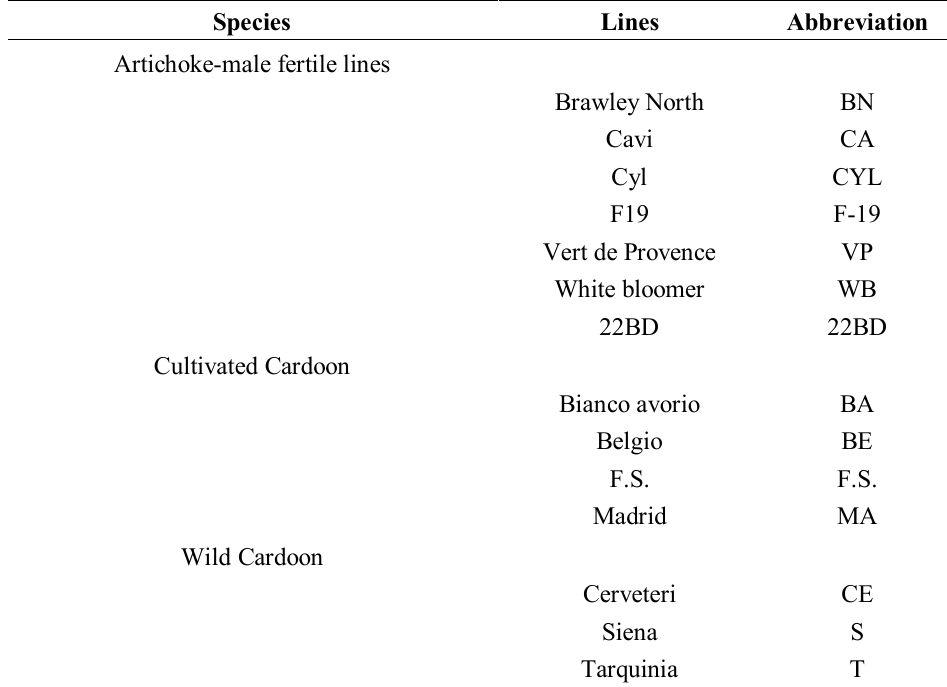
Table 1. Description of selected